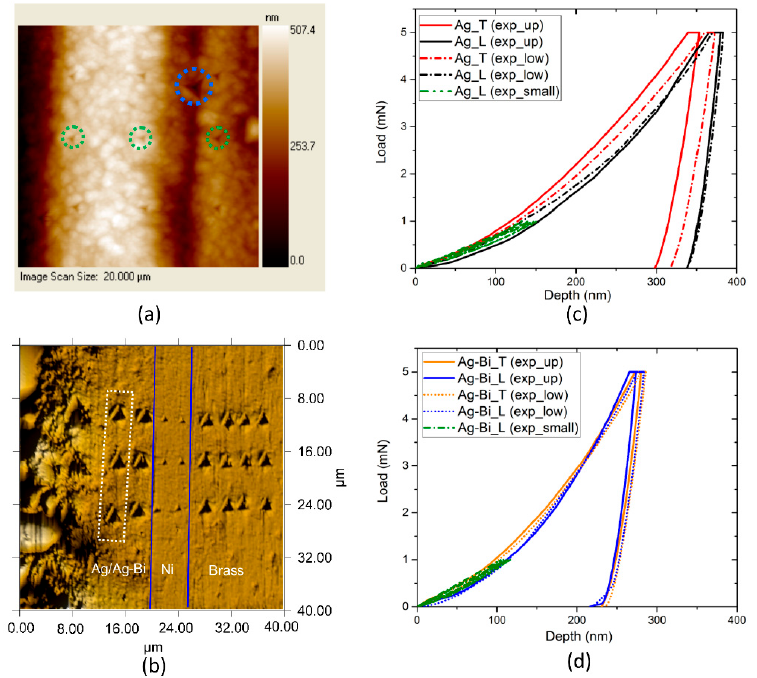
Figure 3. ( a ) Indents (highlighted in circles) in the L direction under SPM with contour color bars indicating the surface height (the indents highlighted in green circles denoted an indentation ~100 nm and the indent highlighted in the blue dotted circle denoted an indentation with P_max = 5 mN); ( b ) indents in the T direction under SPM (the indents highlighted in the white box are used for inverse calculation); ( c ) The upper bound (solid) and lower bound (dotted) of the P-h curves obtained in the two directions for the Ag coating and the small depth (~150 nm) P-h curves in the L direction; and ( d ) the upper bound (solid) and lower bound (dotted) of the P-h curves obtained in the two directions for Ag-Bi coating and the small depth (~120 nm) P-h curves in the L direction.